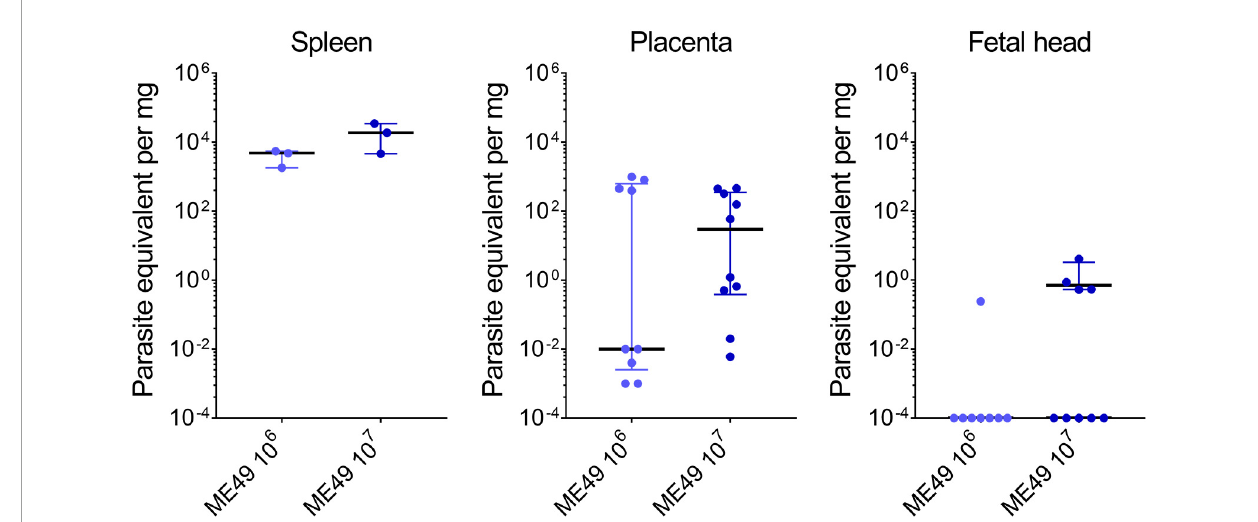
FIGURE7 Parasite load in tissues of Swiss Webster mice infected with T. gondii during pregnancy. Pregnant dams were infected with 10 6 or 10 7 tachyzoites of the T. gondii (ME49 strain) at E8.5 or E9.5 and euthanized 5 days later. Maternal and fetal tissues were collected, and the parasite load assessed by qPCR assay. n = 3 for each infection condition (for spleens); n = 8–10 samples from at least two independent pregnant dams for each infection condition (for placentas and fetal heads). Each symbol represents data from individual mothers or individual placentas and fetuses. Data are presented as median ± interquartile range. Symbols displayed on the x-axis of the last graph represent samples with values below the detection limit of the assay; these samples were not included in the median